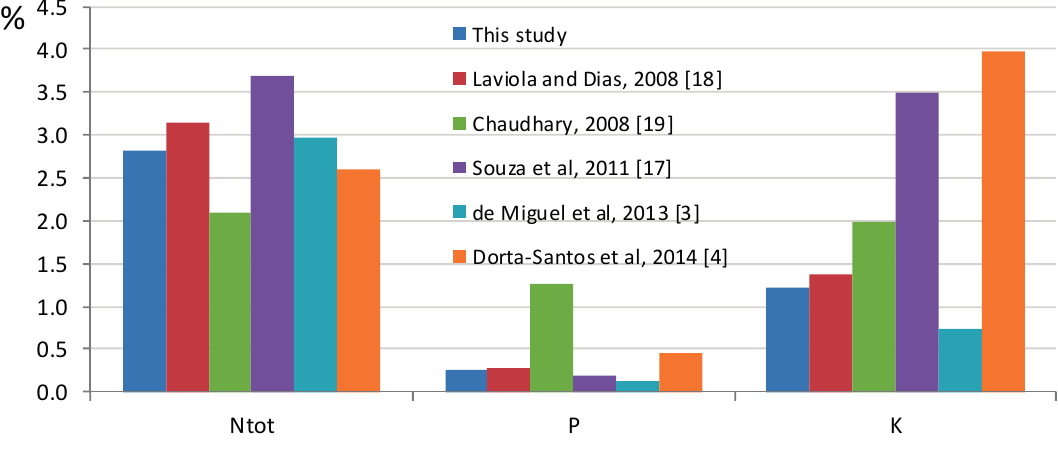
Figure 2. Macronutrient contents in the leaves (%) obtained herein and those reported by other